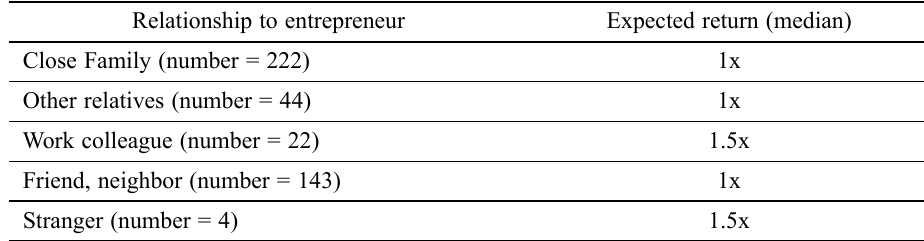
Table 9. Expected returns of Chilean informal investors and their relationships to entrepreneurs Relationship to